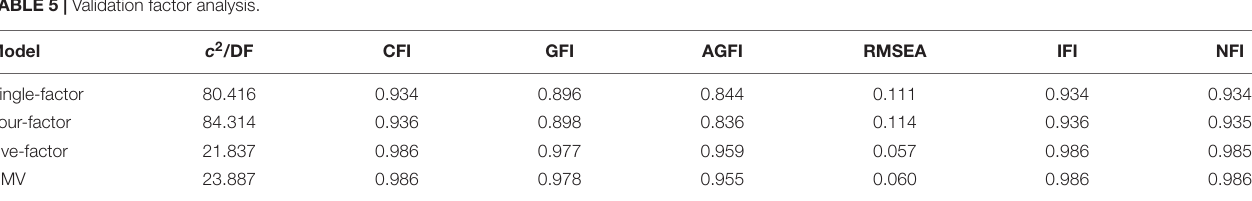
TABLE 5 | Validation factor